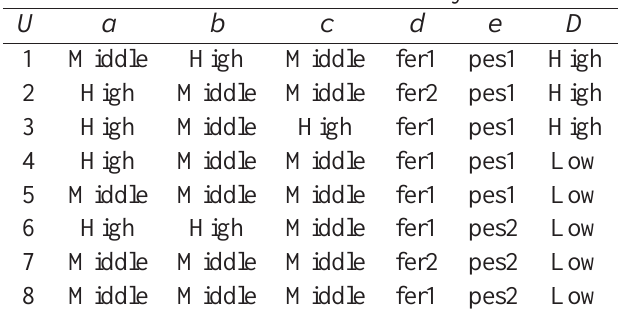
Table 3: A consistent decision